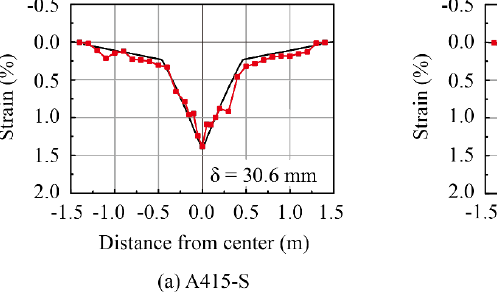
Figure 9. Comparisons between the calculated and experimental results on the axial strain distribu- tion of the AFRP sheet at the calculated ultimate state.